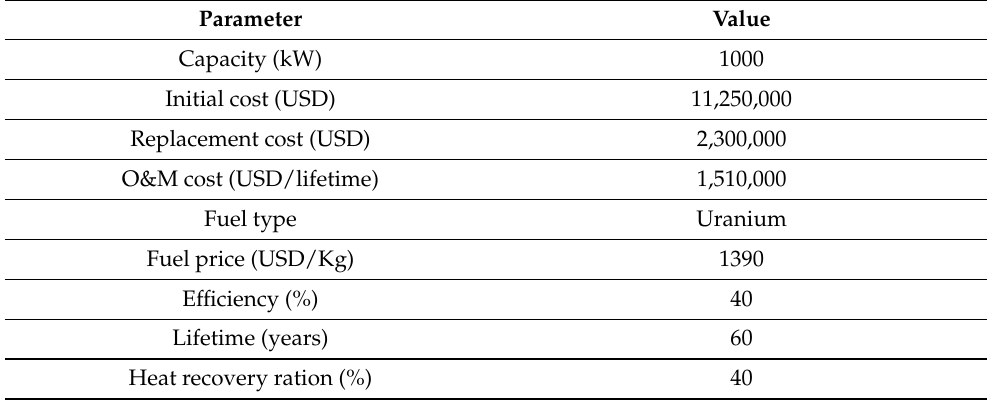
Table 1. MMR design